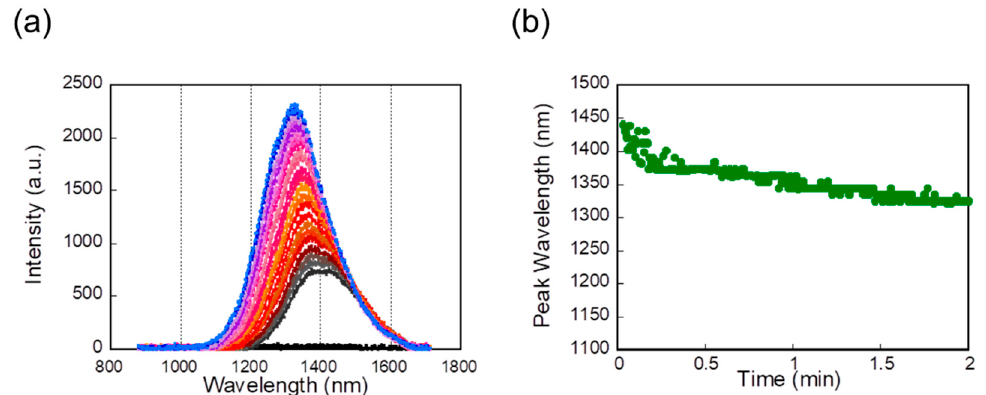
Figure 5. ( a ) Plots of EL intensity as a function of time wavelength for a PbS NIR QLED. (An applied voltage was 1.5 V during light emission.) ( b ) A plot of peak wavelength as a function of time.